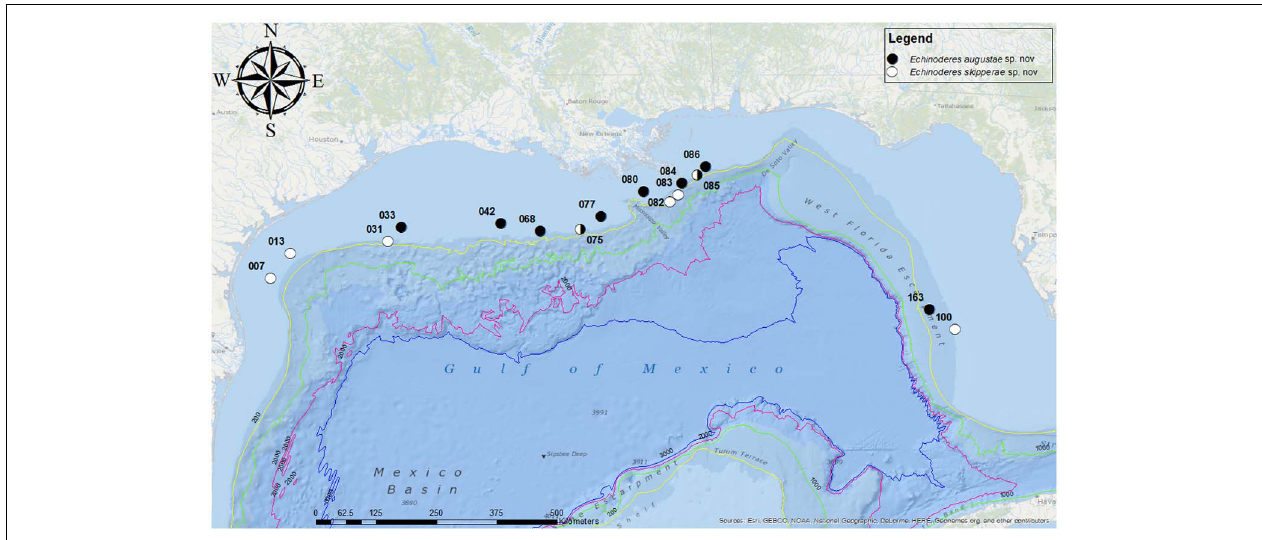
FIGURE 1 | Map showing the sampling locations in the Gulf of Mexico. Station numbers are given for each collection site.